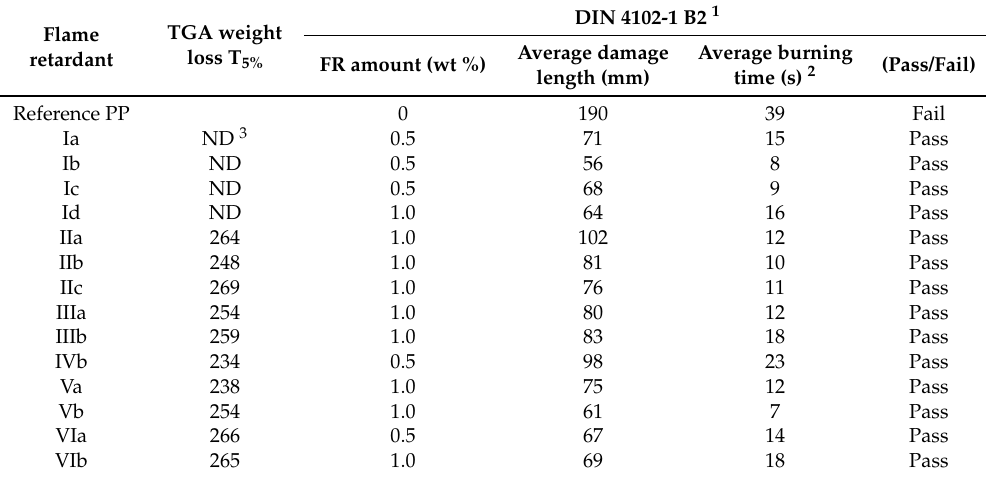
Table 1. Temperature at 5% mass loss (T 5% ) for pure flame retardant (FR) and flame retardancy results for polypropylene (PP) with a given amount of added FR. Flame retardant